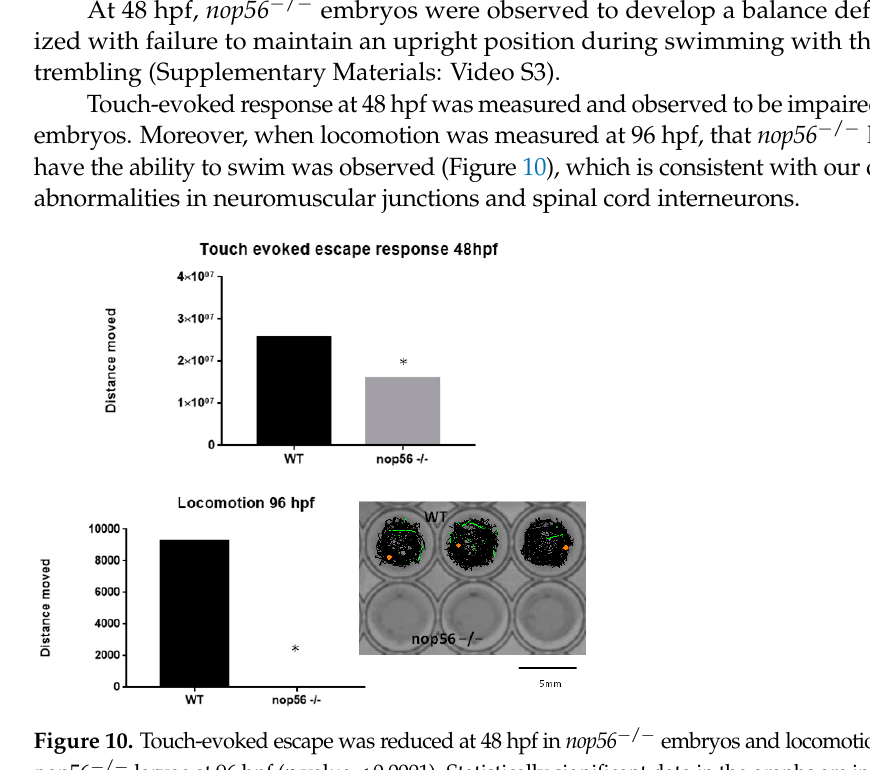
Figure 9. Graphic representation of analysis of mRNA expression by RT-qPCR. ( A ) p21 expression is significantly higher in nop56 − / − larvae between 72 and 120 hpf ( p -value < 0.0001.) ( B ) p53 expression is significantly higher in nop56 − / − larvae between 72 and 120 hpf ( p -value < 0.0001.) ( C ) Microinjection of p53 morpholino restored the expression in nop56 − / − embryos to levels similar to wild type but not the malformations (data not shown). Statistically significant data in the graphs are indicated with a *.